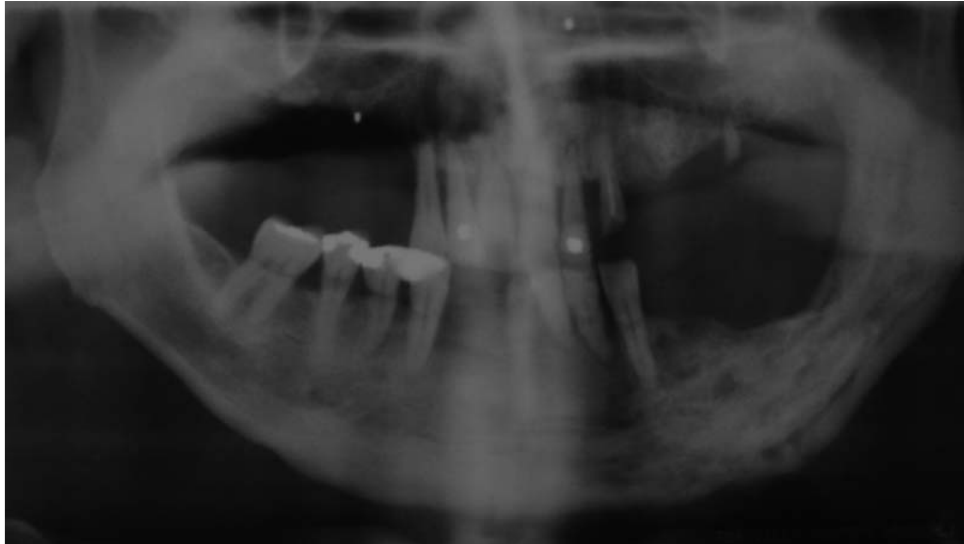
Figure 2 - Panoramic x-ray showing bisphosphonate-induced osteonecrosis in the left